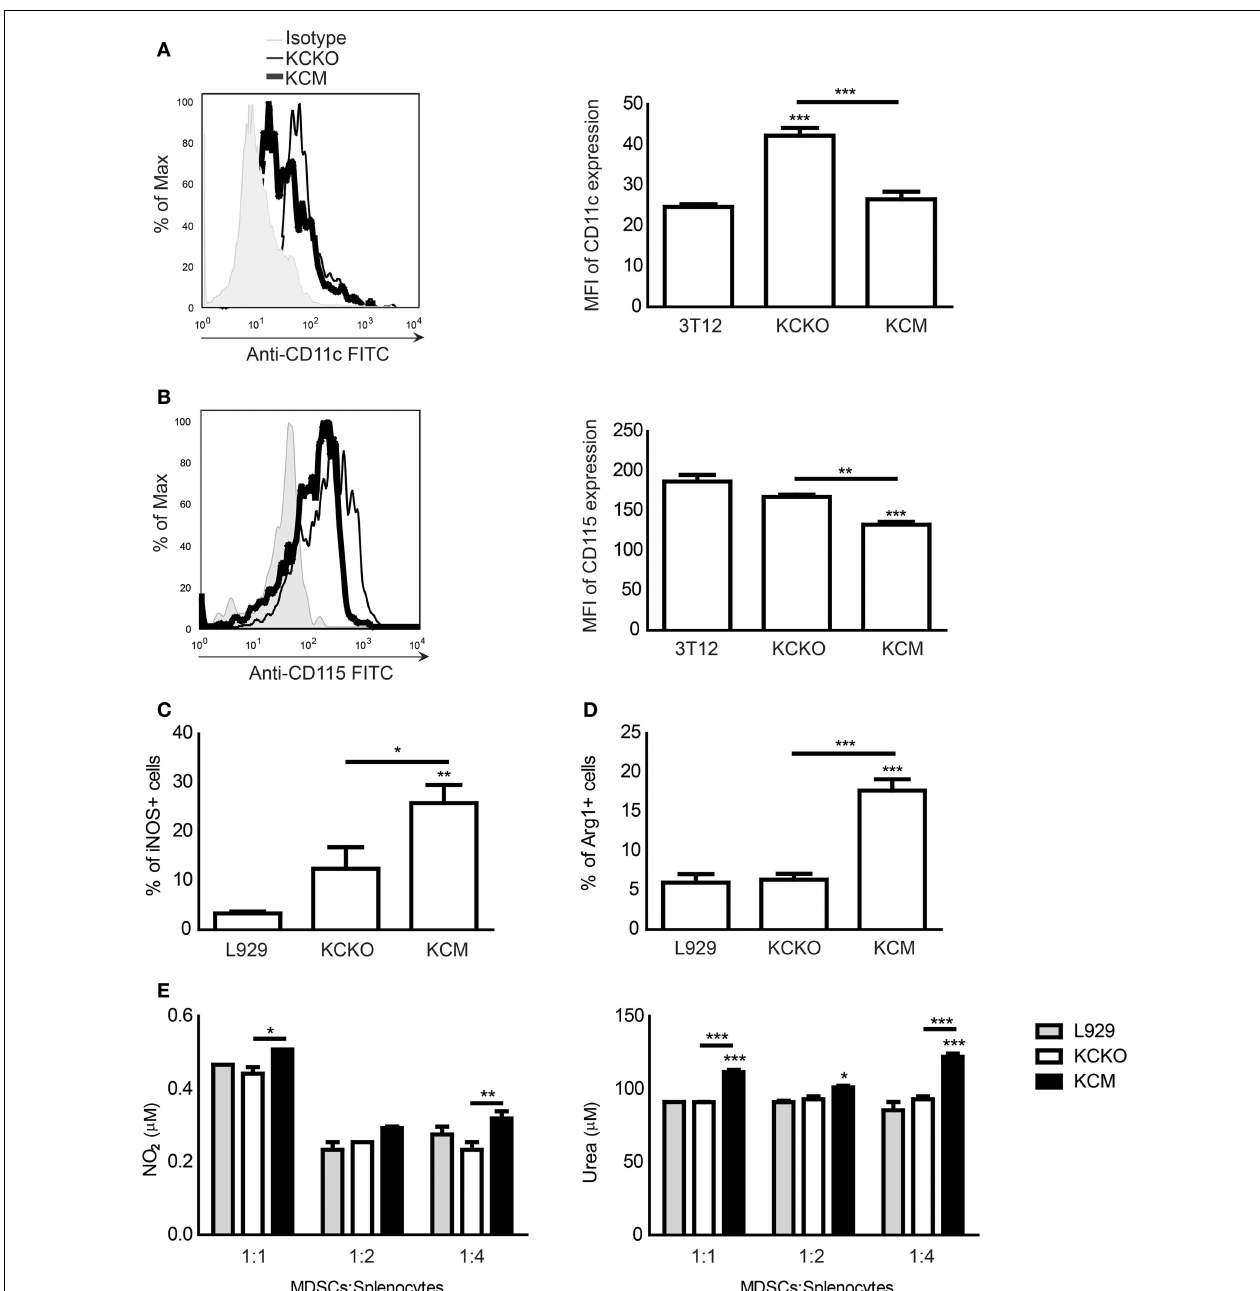
TCCM; (C) Percent of iNOS + cells on Gr1 + CD11b + gated cells treated with variousTCCM; (D) Percent of Arg-1 + cells on Gr1 + CD11b + gated cells treated with variousTCCM. Percentages are not absolute numbers; (E) Gr1 + cells from BM cultures were co-cultured with freshly isolated splenocytes stimulated with anti-CD3 for 3days at ratios of 1:1, 1:2, and 1:4 for 72h.The nitric oxide concentration was assessed in the co-culture supernatant and the urea concentration was assessed in the cell lysate. One representative experiment out of three is shown. Mean and standard error are plotted. * p < 0.05, ** p < 0.01, and *** p < 0.001 for statistically significant differences from control (L929) levels unless indicated by the line above the